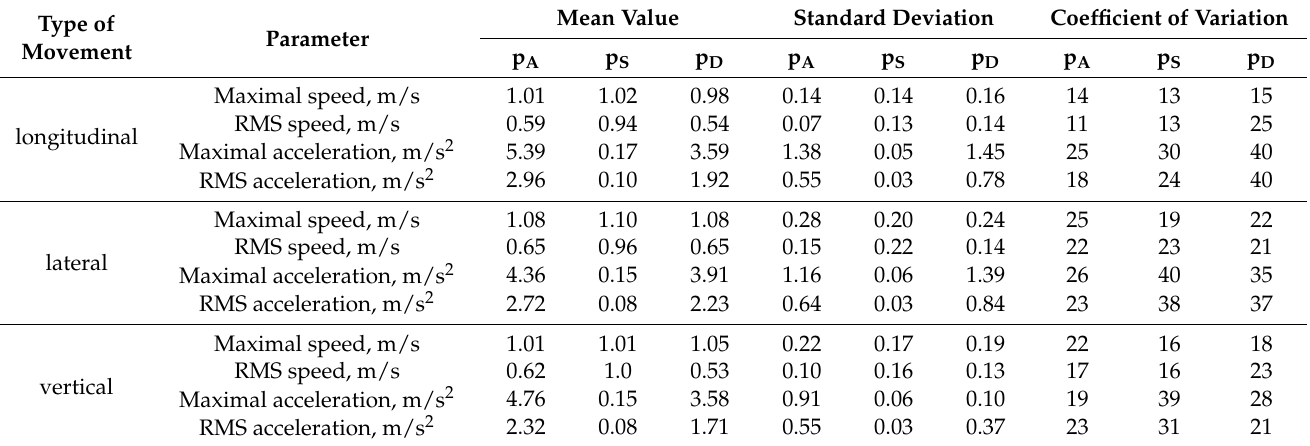
Table 1. Values of the determined parameters for reaching